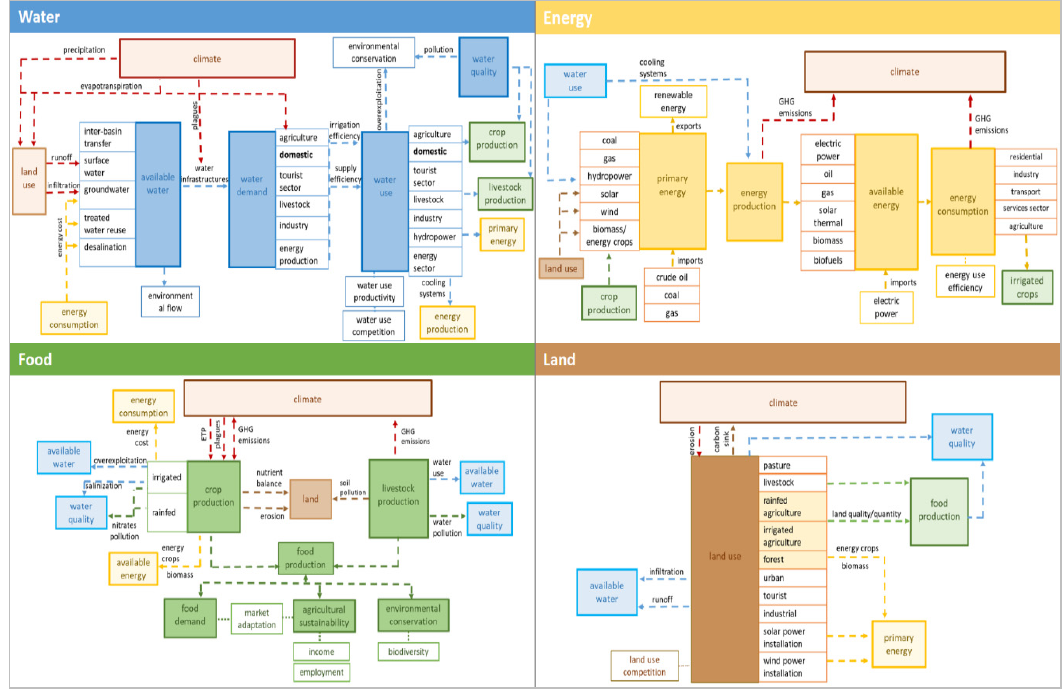
Figure 3. Andalusian conceptual model: water, energy, food, and land sub-models. Source: our own elaboration.